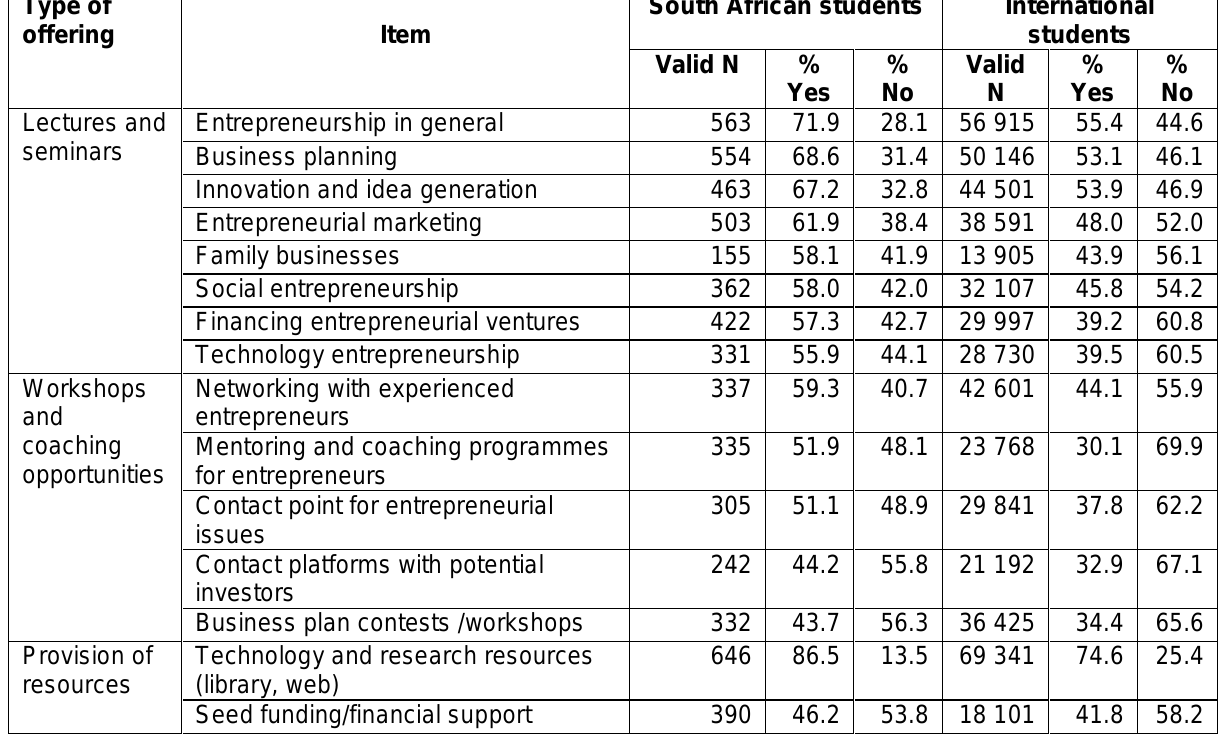
Table 4 Utilisation of